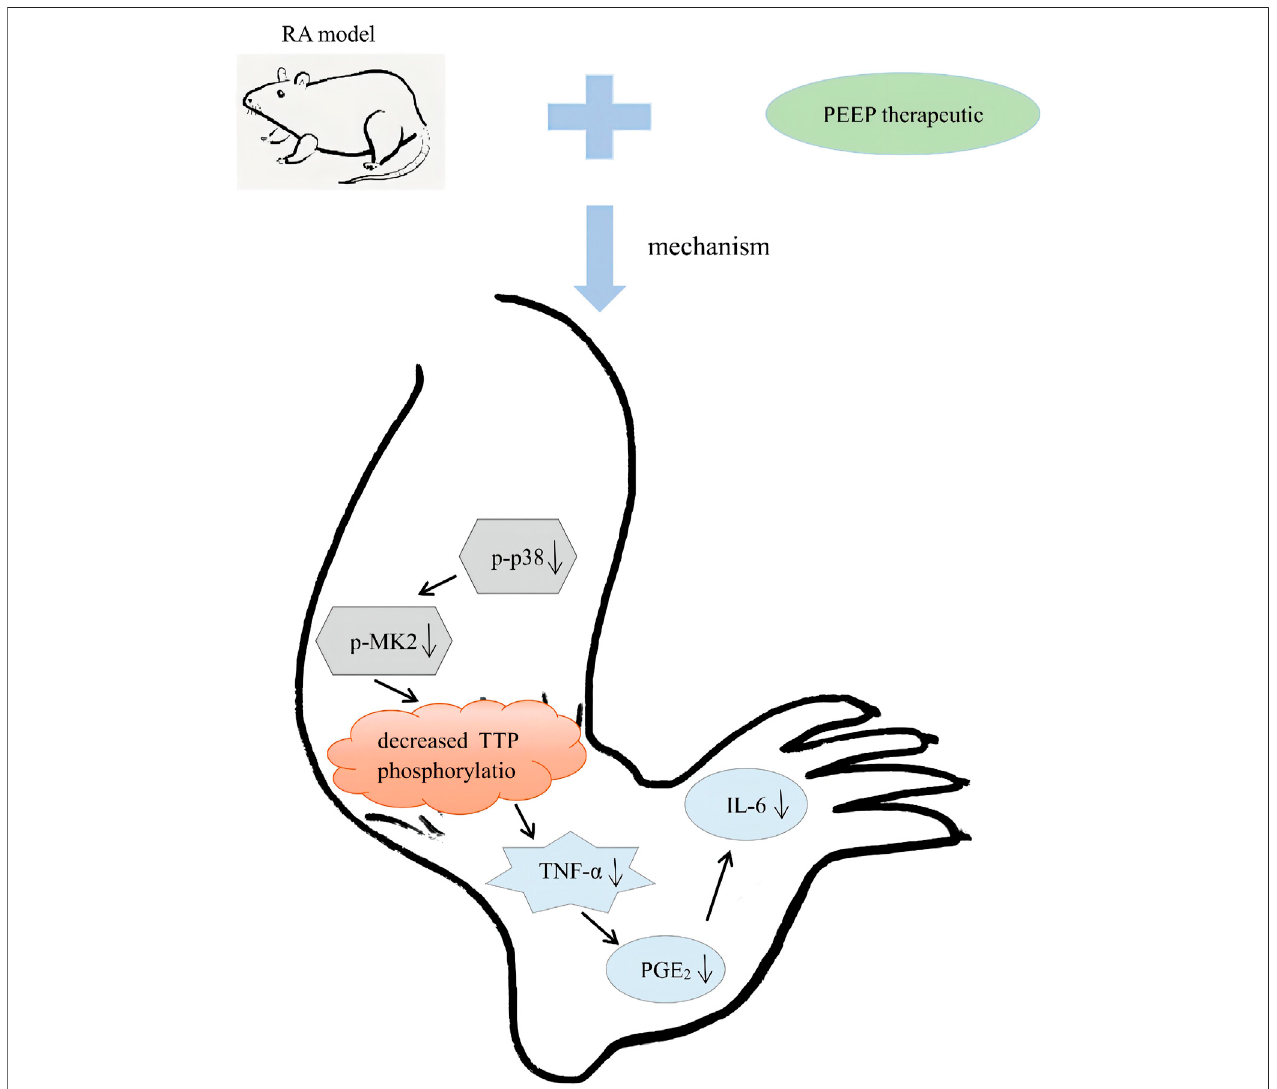
FIGURE 10 | Schematic diagram of the mechanism of action of PEEP in vivo